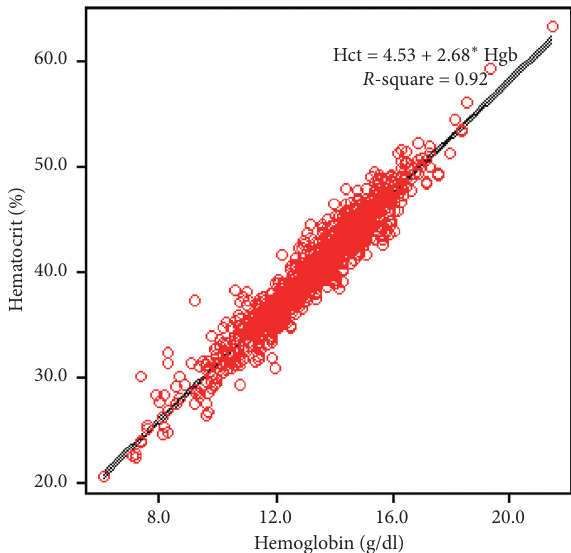
Figure 2: Scatter plots of the 1,141 paired measurements of hematocrit and hemoglobin with best-fitting